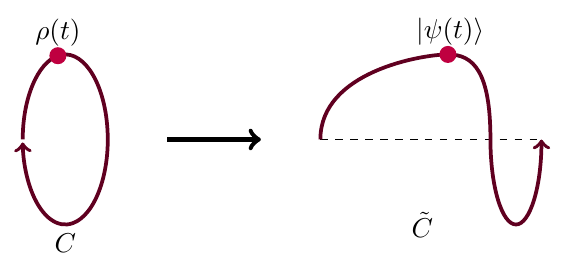
Figure 3. A curve C of density matrices gives rise to a parallel lift ~ C of puri(cid:12)cations. Even if C is closed, it may be impossible for ~ C to be, because of curvature in the Uhlmann holonomy. The integral on the right-hand side is convergent because (cid:26) is a positive operator. Along with an initial condition j (0) i that puri(cid:12)es (cid:26) (0), this equation may be solved to give a curve in H (cid:10) H 0 , and it may be veri(cid:12)ed that this curve is a parallel lift of C . Of